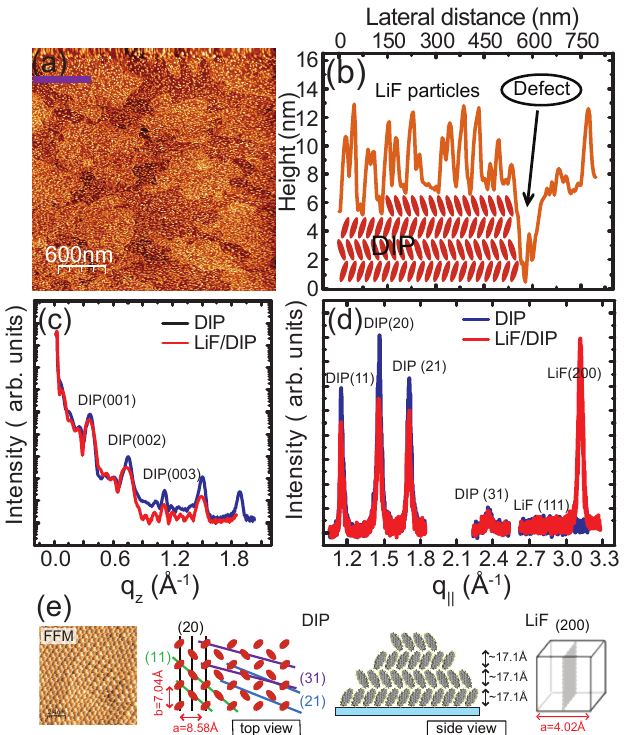
Figure 1. ( a ) AFM micrograph of the bilayer configuration LiF/DIP/SiO 2 shows the submonolayer coverage of nanometer sized LiF islands. The large flat plateau islands of DIP can be observed. ( b ) The height profile corresponding to the line visible in ( a ) showing the height steps between different DIP monolayers and the peaked height fluctuations (20–60 Å) due to LiF. A defect site of the organic thin film is indicated showing the total thickness of the organic film ( ∼ 68 Å, up to four monolayers with 17.1 Å per monolayer) ( c ) X-ray reflectivity (“specular diffraction”) data from two samples, a single film of DIP/SiO 2 and a LiF/DIP/SiO 2 bilayer configuration, labelled with the pseudo-Bragg positions observed. ( d ) The grazing incidence X-ray diffraction data of single layer and bilayer films of DIP/SiO 2 , with observed features assigned to the DIP and LiF crystal lattice planes. Centre positions of the observed in-plane peaks were fitted with Lorentzian distribution functions. ( e ) Friction force micrographs of DIP, showing the regular arrangement of molecules within an island, with schematic representation of the molecular arrangement in-plane and out- of-plane in the observable crystallographic planes in real space for the DIP herringbone structure and LiF FCC structure. The measured monolayer thickness and expected tilt angle for DIP is also shown